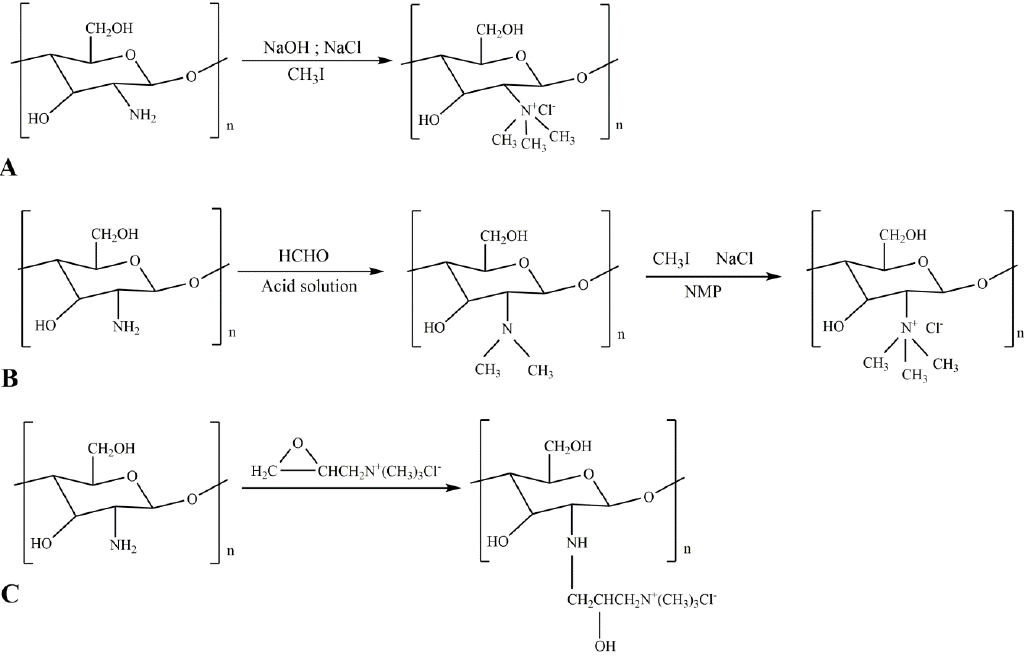
Figure 5. Reaction equations for quaternized chitosan derivatives. ( A ), N,N-trimethyl chitosan (TMC) direct quaternary ammonium salt substitution method; ( B ) TMC N-alkylation; ( C ) chitosan 2,3-epoxypropyl trimethyl ammonium chloride (GTA) ring opening method.